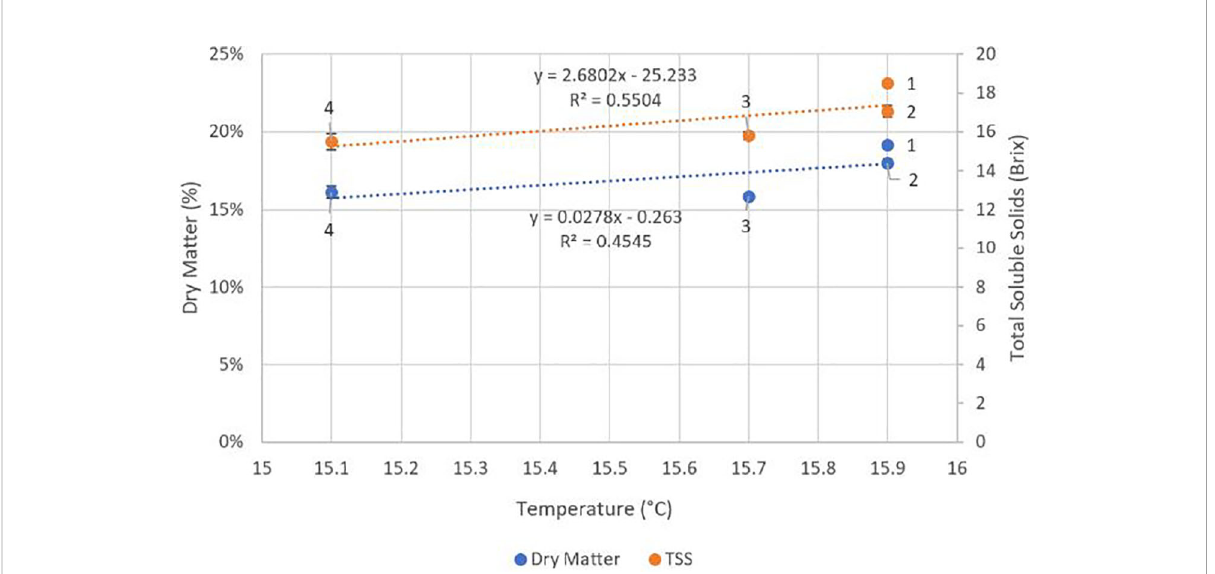
FIGURE 5 Effect of average temperature at each of the four locations across an altitude/distance from PCS boundary gradient on fruit dry matter content and total soluble solids (TSS). At each location n = 60, 30 fruits per tree. Bars represent one standard error for each location. PCS, protected cropping